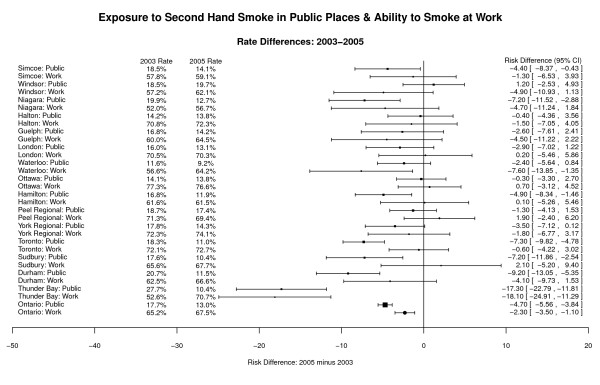
Exposure to Second Hand Smoke in Public Places, Ability to Smoke at Work, Rate Differences, 2003-2005 [9].